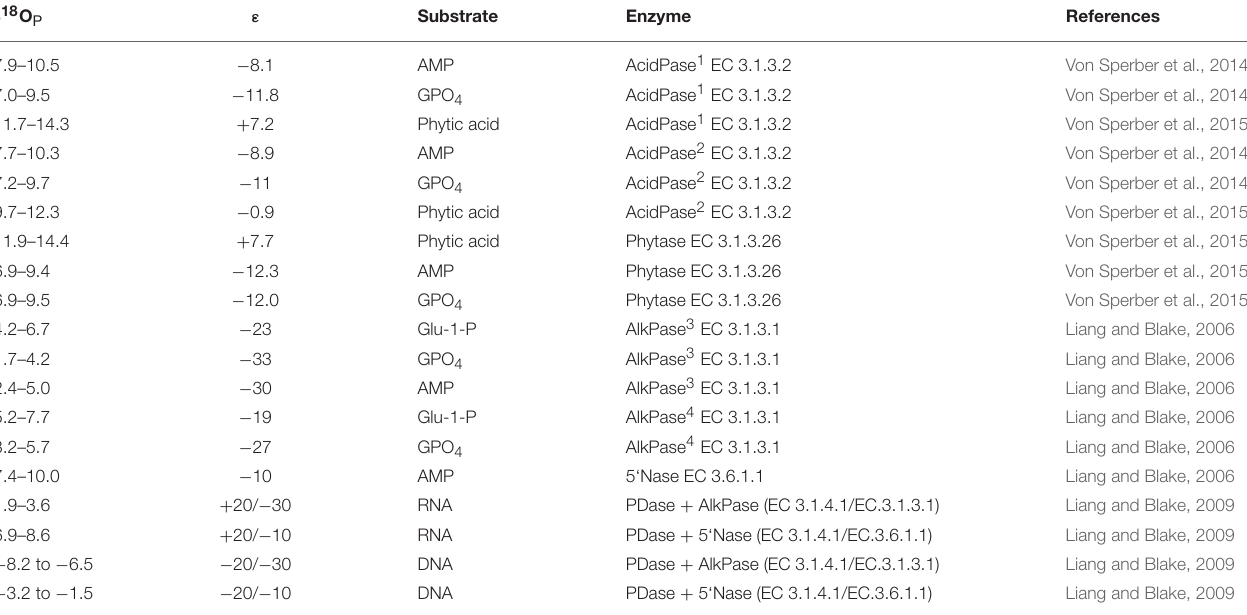
TABLE 3 | Examples of mass balance calculations* for the oxygen isotopic composition of phosphate ( δ 18 O P ; ‰ ) released by enzymatic hydrolysis for different enzymes and substrates using literature values for isotopic fractionation ( ε ). δ 18 O